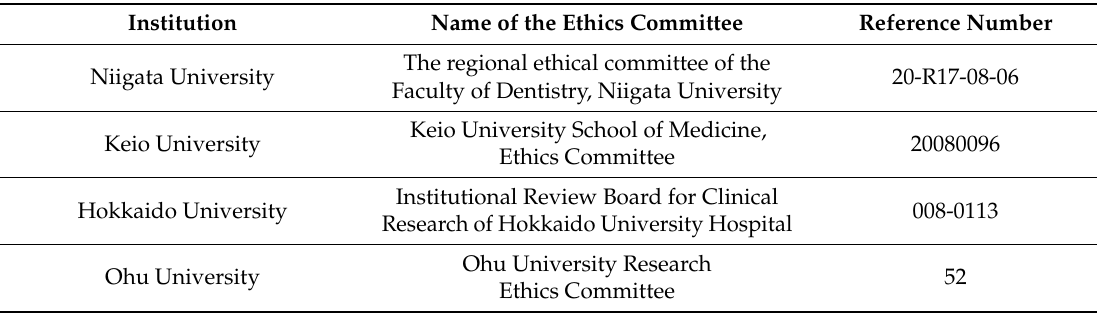
the clinical attachment level, Figure S2: ROC curves by the selected six values, Figure S3: ROC curves for the diagnosis of periodontal disease by the selected site, Figure S4: ROC curves for clinical parameters by the selected site, Table S1: Constructed models, Table S2: Generalized linear model to predict the mean value of the clinical attachment level by the selected